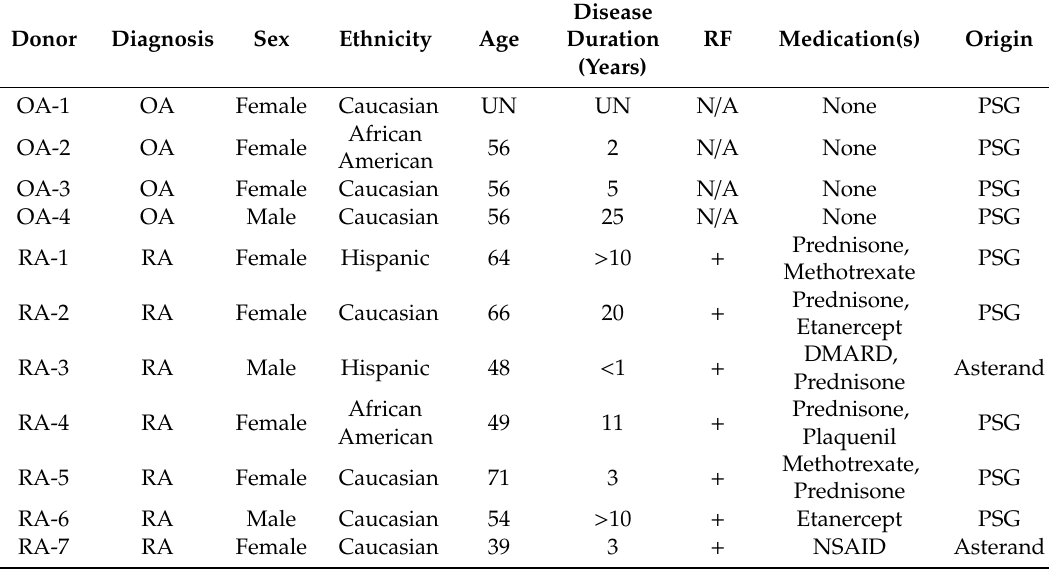
Table 1. Characteristics of rheumatoid arthritis–fibroblast-like synoviocytes (RA-FLS) and osteoarthritis–FLS (OA-FLS)